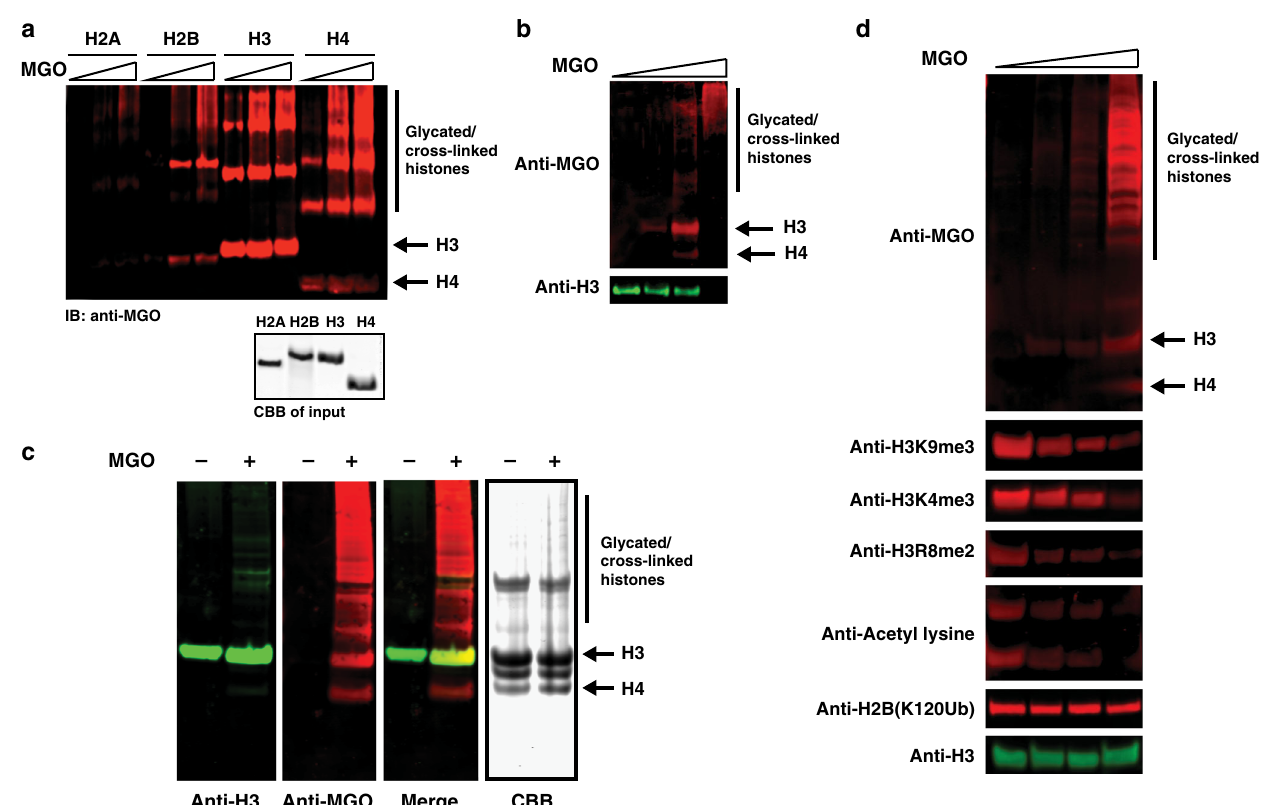
Fig. 2 Histone H3 and H4 are prime targets for glycation in vitro and in cellulo. a Glycation of free histones. Recombinant puri fi ed histones (indicated in the coomassie brilliant blue stained SDS-PAGE) were incubated with increasing concentrations of MGO (0.1, 0.5 or 1 mM, corresponding to 4:1, 1:1 or 1:2 sites: MGO stoichiometry, respectively) for 12 h at 37 °C. Analysis was performed by SDS-PAGE followed by western blot with anti-MGO. b Reconstituted nucleosomes were treated with 0, 0.5, 5 or 100 mM of MGO (corresponding to 1:2, 1:20 or 1:400 sites:MGO stoichiometry, respectively) for 72 h at 37 °C, after which the nucleosomes were analyzed as described for free histones. c Histone glycation in 293T cells after 0.5 mM MGO treatment for 24 h. Histones were extracted by high salt and analyzed by coomassie or western blotted with the indicated antibodies. d 293T cells were incubated with 0, 0.25, 0.5 or 1 mM of MGO for 12 h at 37 °C, after which histones were extracted with high salt and analyzed by western blot with the indicated histone